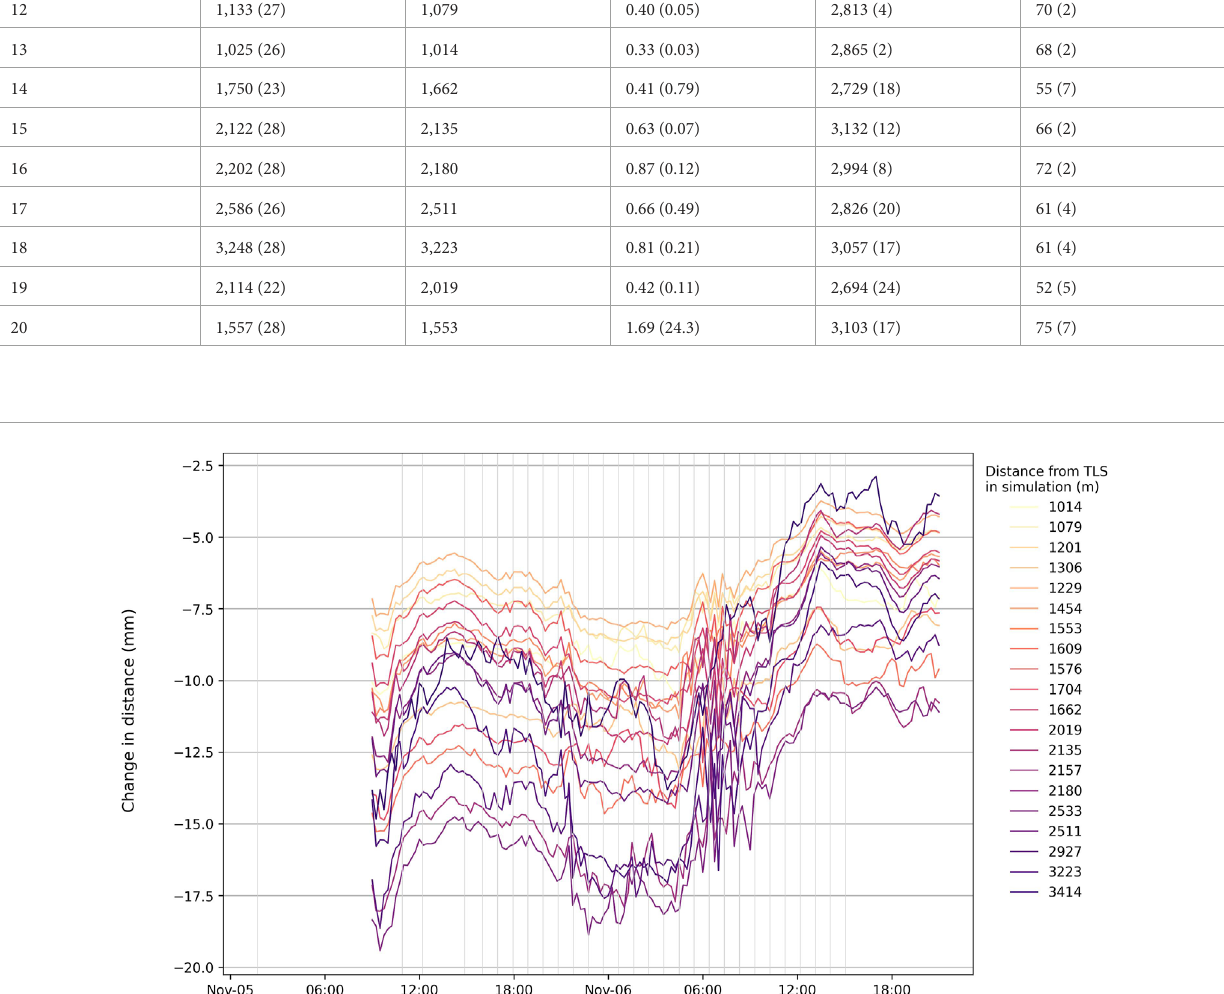
Frontiers in Earth